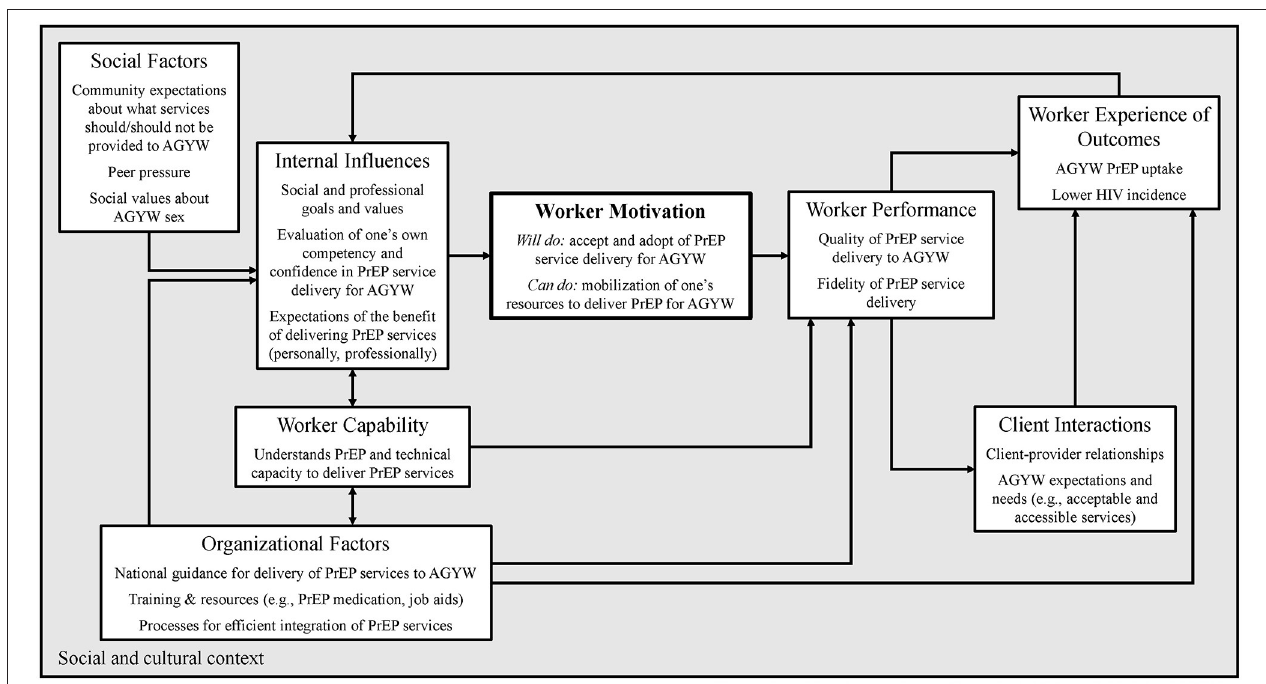
FIGURE 2 | Health care worker motivation and values alignment. Figure adapted from Franco, Bennet, Kanfer, Social Science & Medicine 54